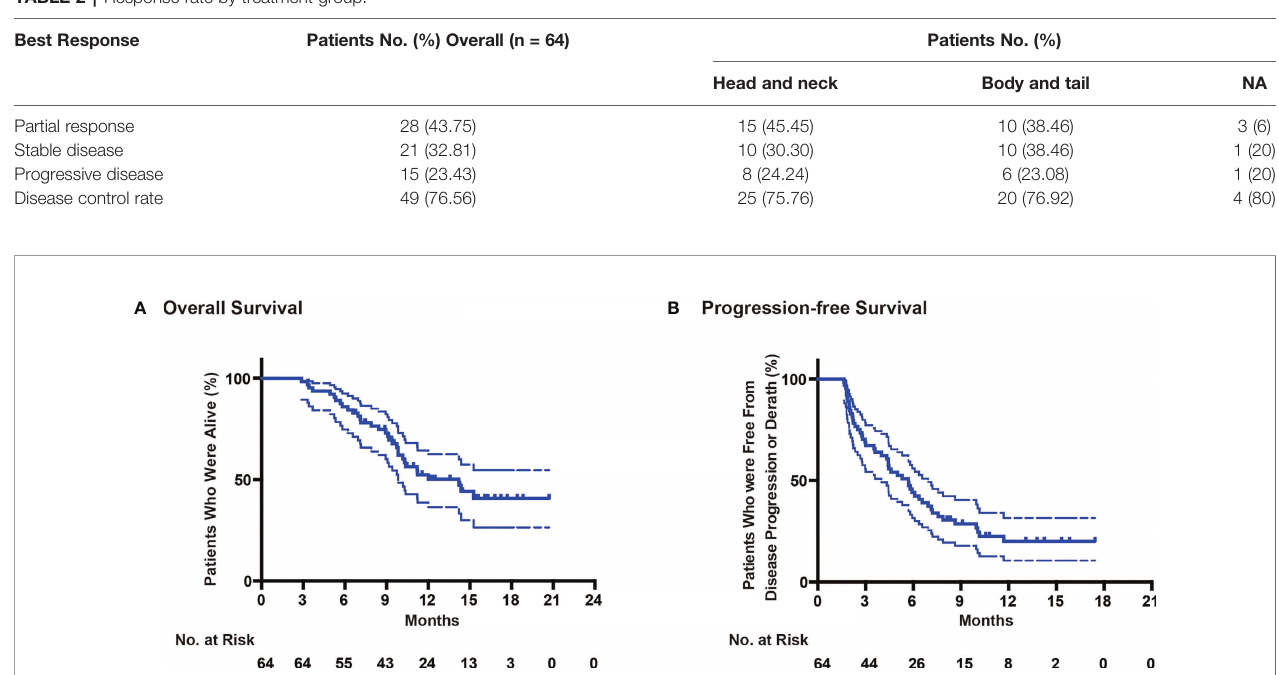
TABLE 2 | Response rate by treatment group.